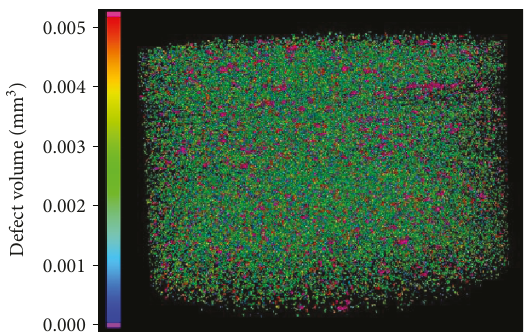
Figure 1: Computed tomography showing microscopic pore structures of